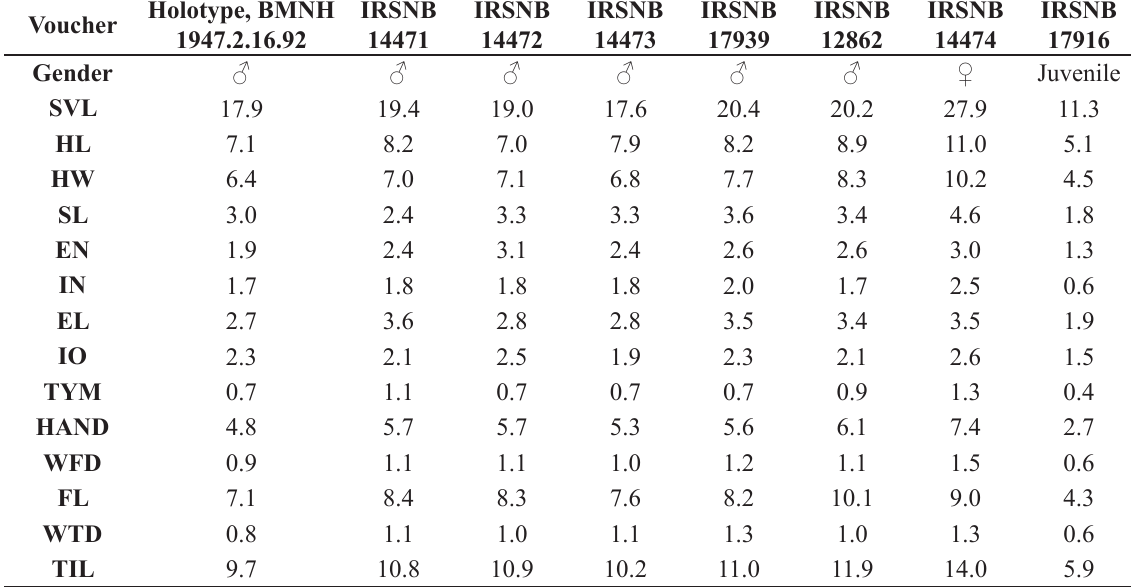
Table 2. Measurements (in mm) of the holotype of Pristimantis marmoratus (Boulenger, 1900) and new specimens assigned to the nominal species (see text for details).